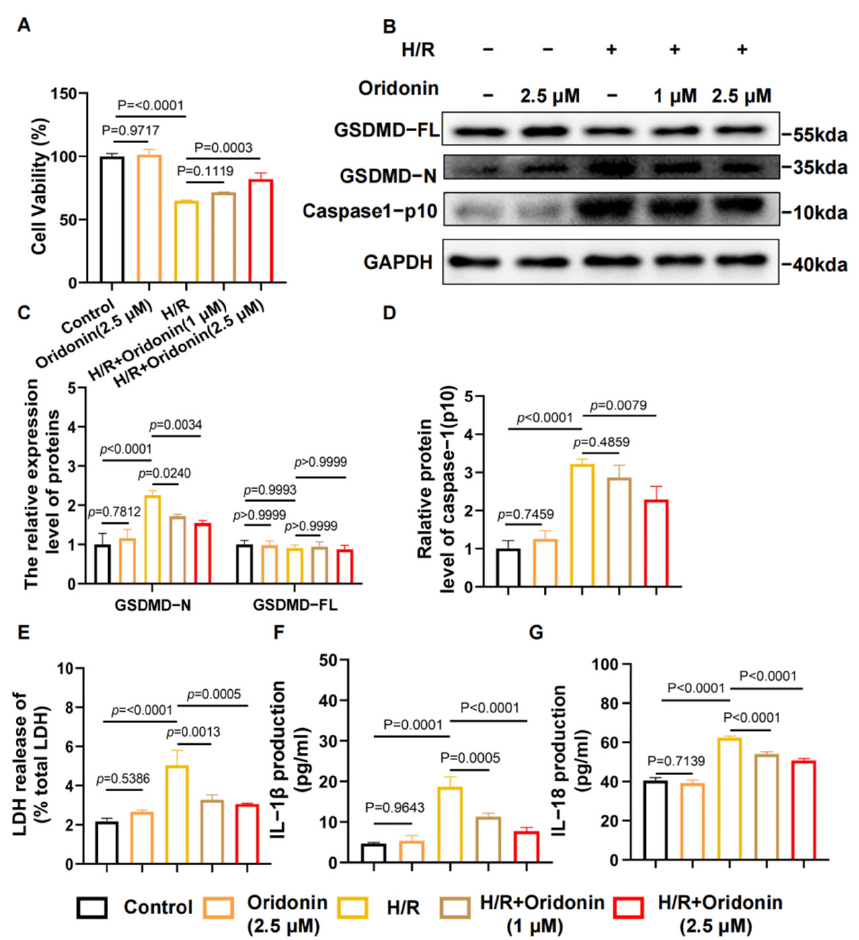
Figure 3. Oridonin protected cardiomyocytes from H/R-induced pyroptosis. ( A ) Cell viability of NRCMs from each group. ( B ) Representative western blot results of GSDMD-FL, GSDMD-N and cleave-caspase-1 from each group. ( C ) Densitometric quantification of GSDMD-N and GSDMD-FL based on ( B ). ( D ) Densitometric quantification of cleave-caspase-1 based on ( B ). ( E ) Percent LDH release in cell supernatants from each group. ( F ) Concentration of IL-1 β in the cell supernatants from each group. ( G ) Concentration of IL-18 in the cell supernatants from each group. All samples are from NRCMs. The protein level was standardized using GAPDH. In all cases, the data are expressed as the mean ±